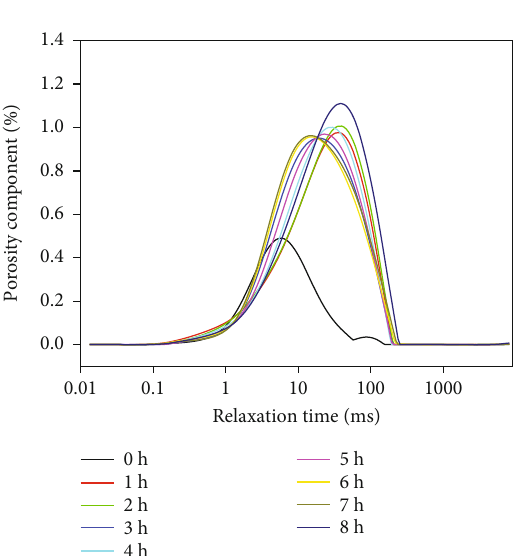
ff erent leaching times.